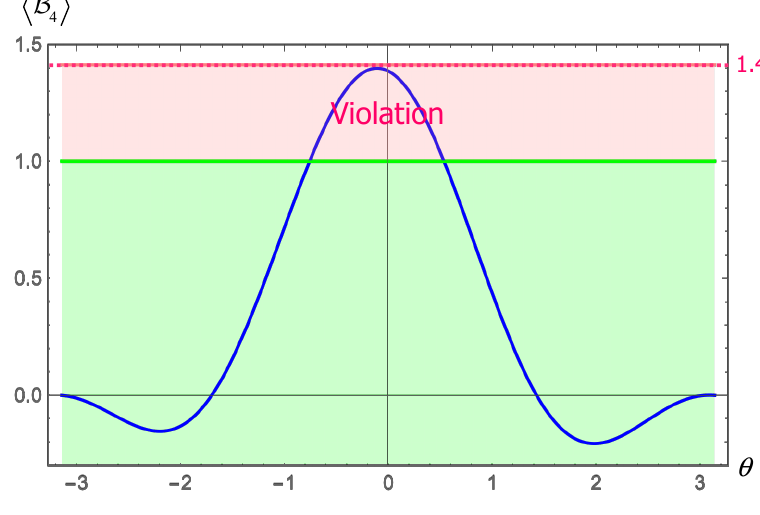
Figure 2. The result of the Bunch–Davies